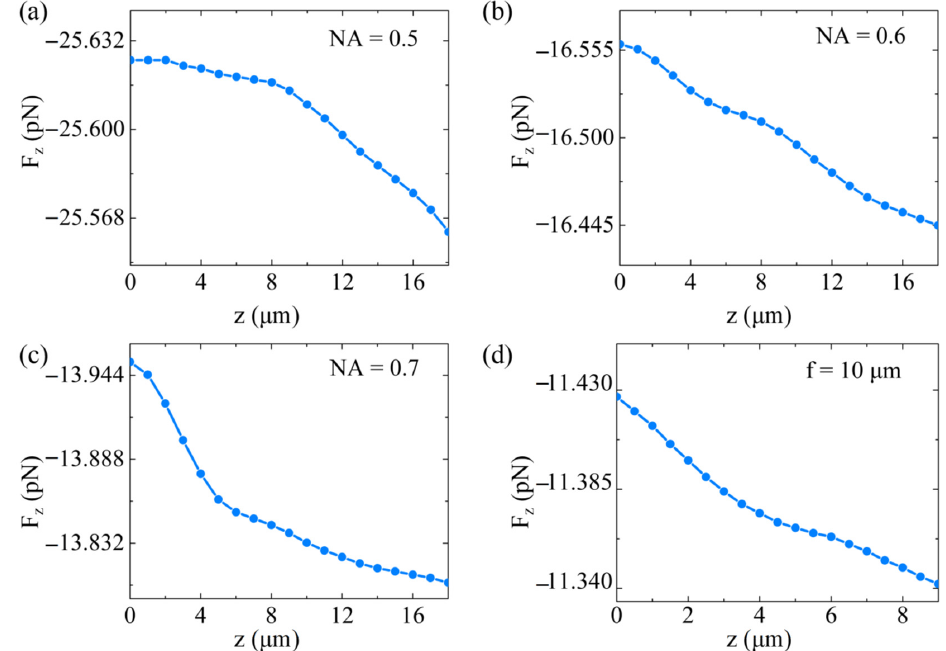
Figure A2. The OPF for ( a ) NA = 0.5, ( b ) NA = 0.6, ( c ) NA = 0.7, and ( d ) f = 10 μ m, respectively. The incident light power for NA = 0.5, 0.6, and f = 10 μ m is 1.5 W, and for NA = 0.7 is 2 W.